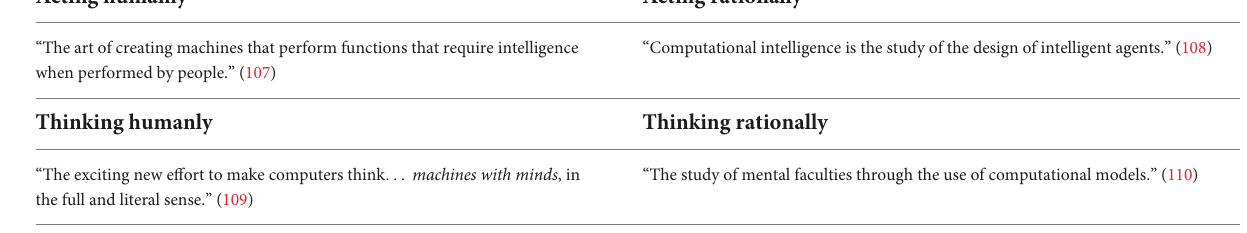
TABLE 1 Definitions of Artificial Intelligence (AI) by four goal based categories (8). Acting humanly